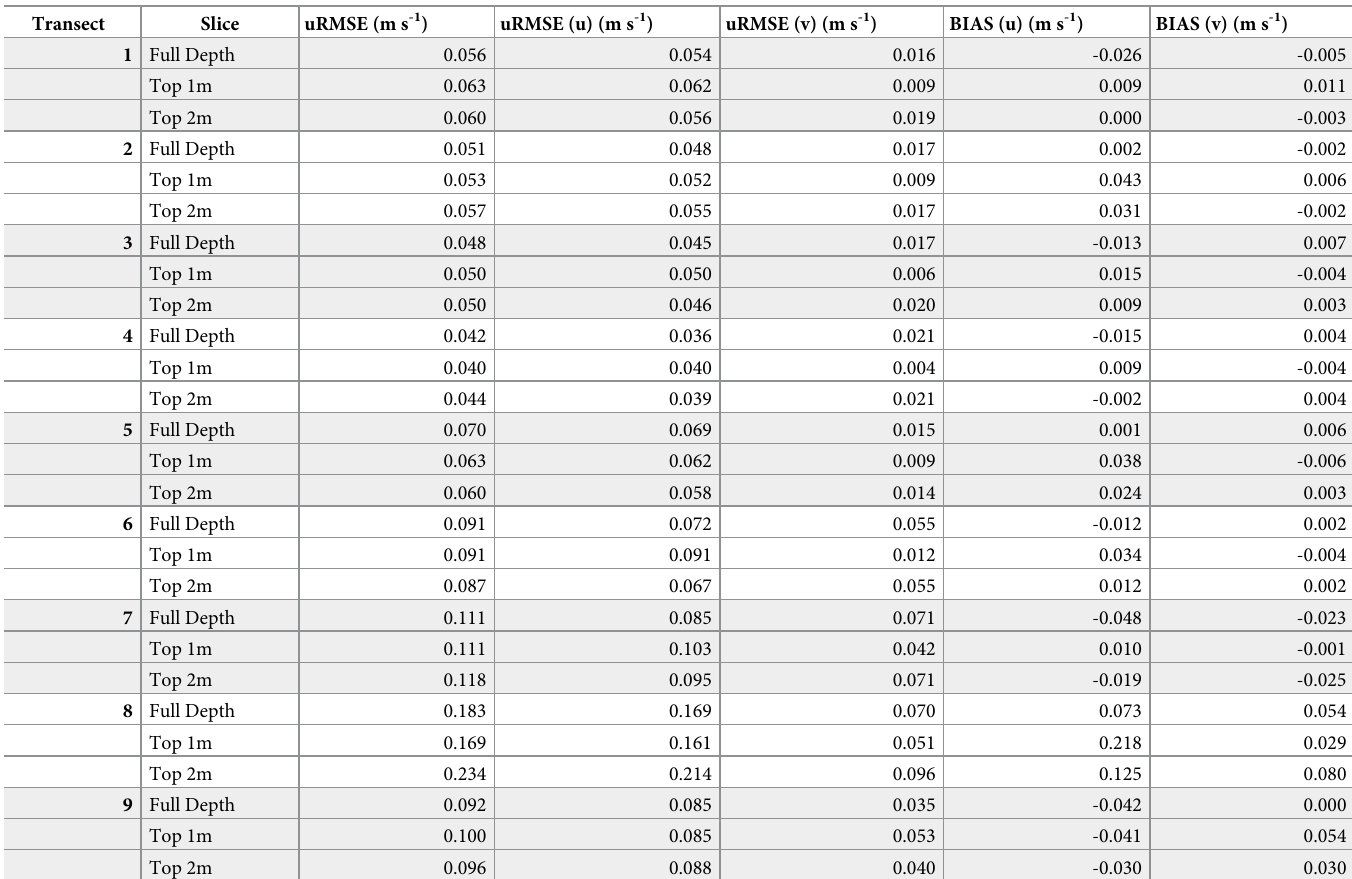
Table 1. Metrics for hydrodynamic calibration.